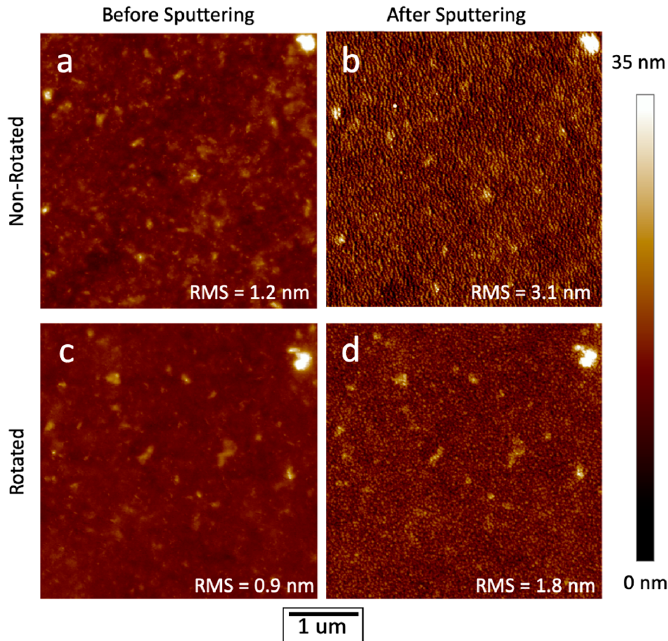
Figure 4. Atomic force microscopy (AFM) images of the thin films ( a , c ) before sputtering, ( b ) after sputtering with a stationary sample, and ( d ) after sputtering with Zalar (in-plane) sample rotation. AFM images are at the same positions before and after sputtering, meaning ( a , b ) are the same area of the sample, as well as ( c , d ). The surface defect that in the upper-right corner was included in the images to show any offset between the corresponding sets of AFM images. The height scale bar on the right applies to all AFM images.